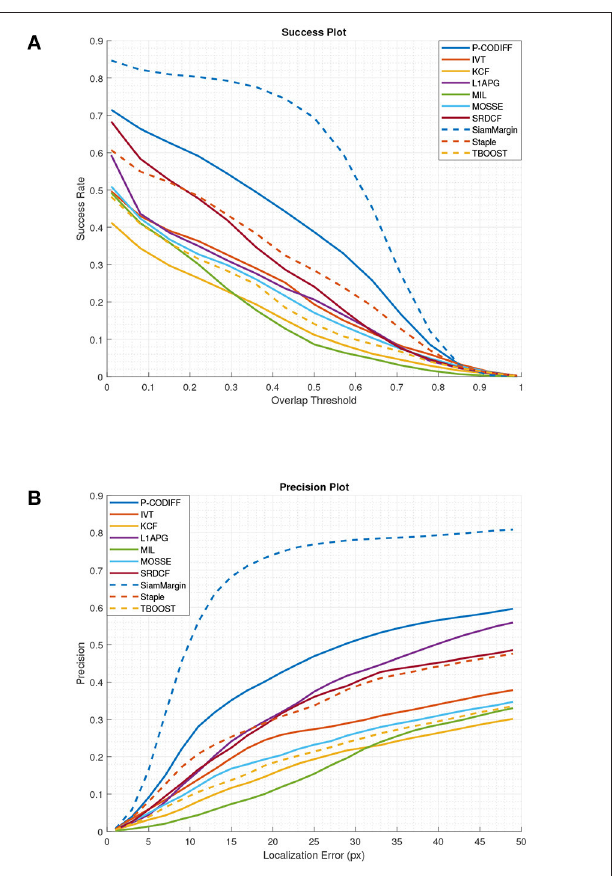
FIGURE 4 | Success and precision plots of various methods. (A) Success vs. overlap threshold plots of various methods. (B) Precision vs. localization error plots of various